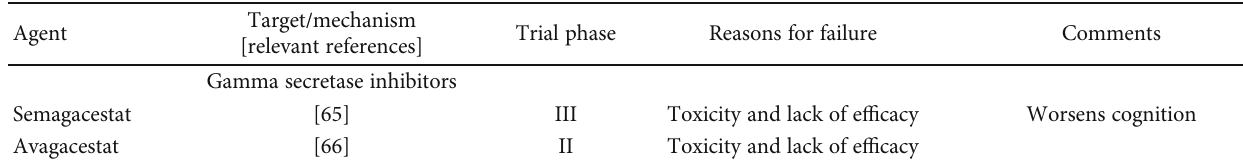
Table 2: Recent clinical trial failures involving the beta-amyloid